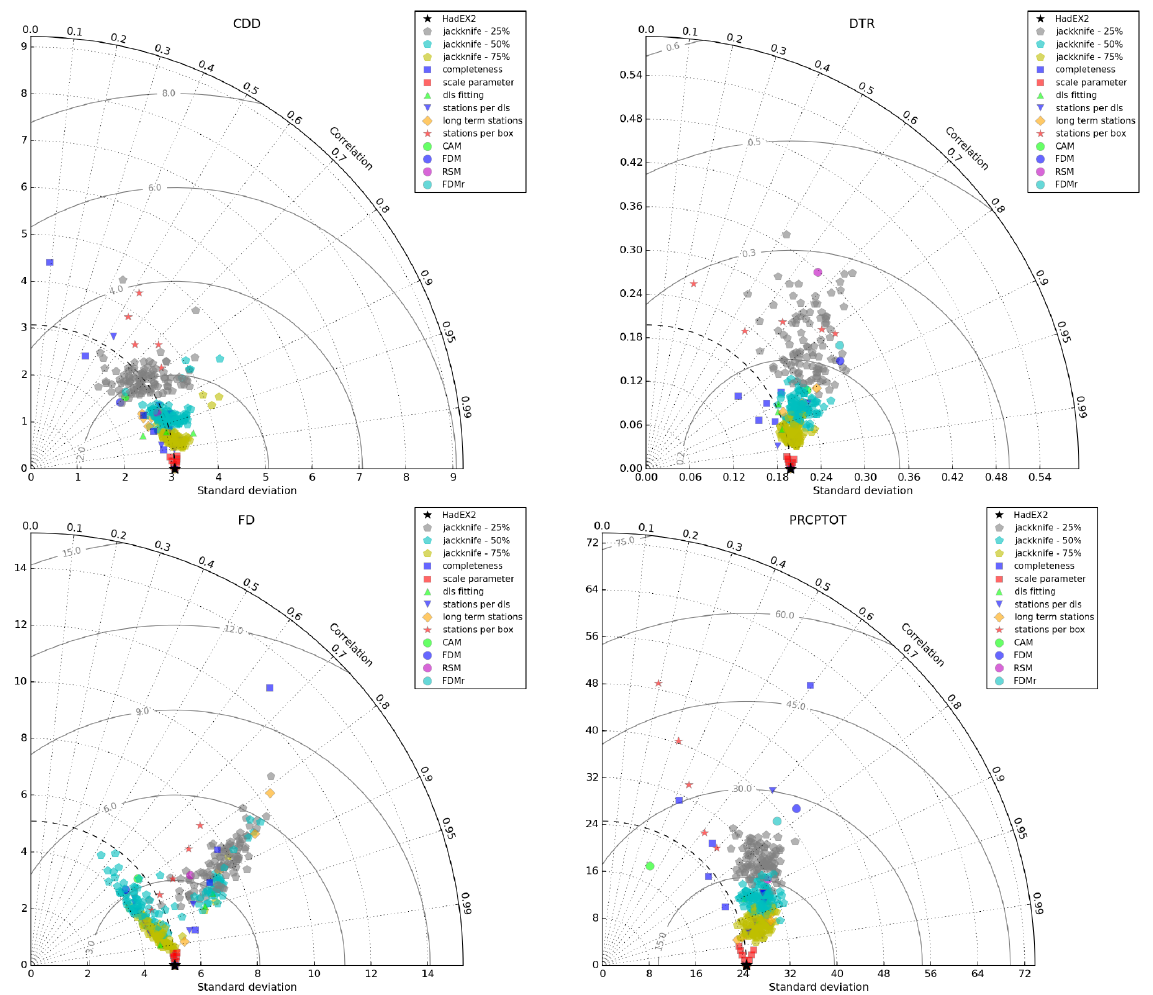
Figure 20. The Taylor Diagram using the global average timeseries for each choice. Each of the different methodological choices in the previous sections are shown using a different symbol and colour as indicated in the legend. Diagrams for CDD (Consecutive Dry Days), DTR (Diurnal Temperature Range), FD (Frost Days) and PRCPTOT (Total Annual Precipitation) are